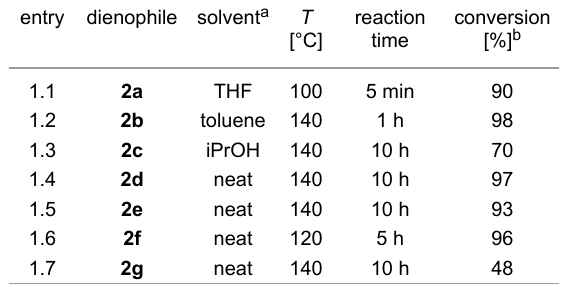
Table 1: Reagents, reaction conditions and results for small scale batch reaction of myrcene with various dienophiles. entry dienophile solvent